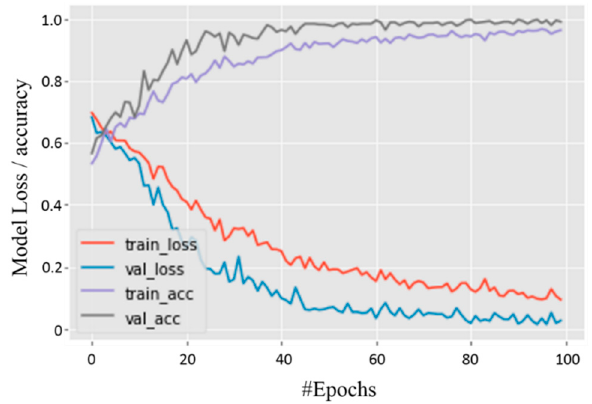
Figure A2. Training and Validation metrics across 100 epochs for the CNN. This plot shows that the model loss decreases over the epochs, and approaches zero at 100 epoch mark. Similarly, model accuracy approaches 1 as number of epochs increases, and plateaus at 80 epochs.